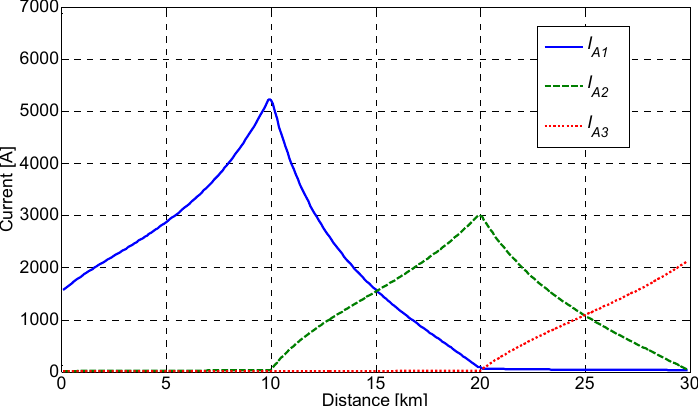
Figure 4. Currents obtained in simulations of the autotransformers ATS1, ATS2 and SATS for different fault locations. Fault between catenary and rail.